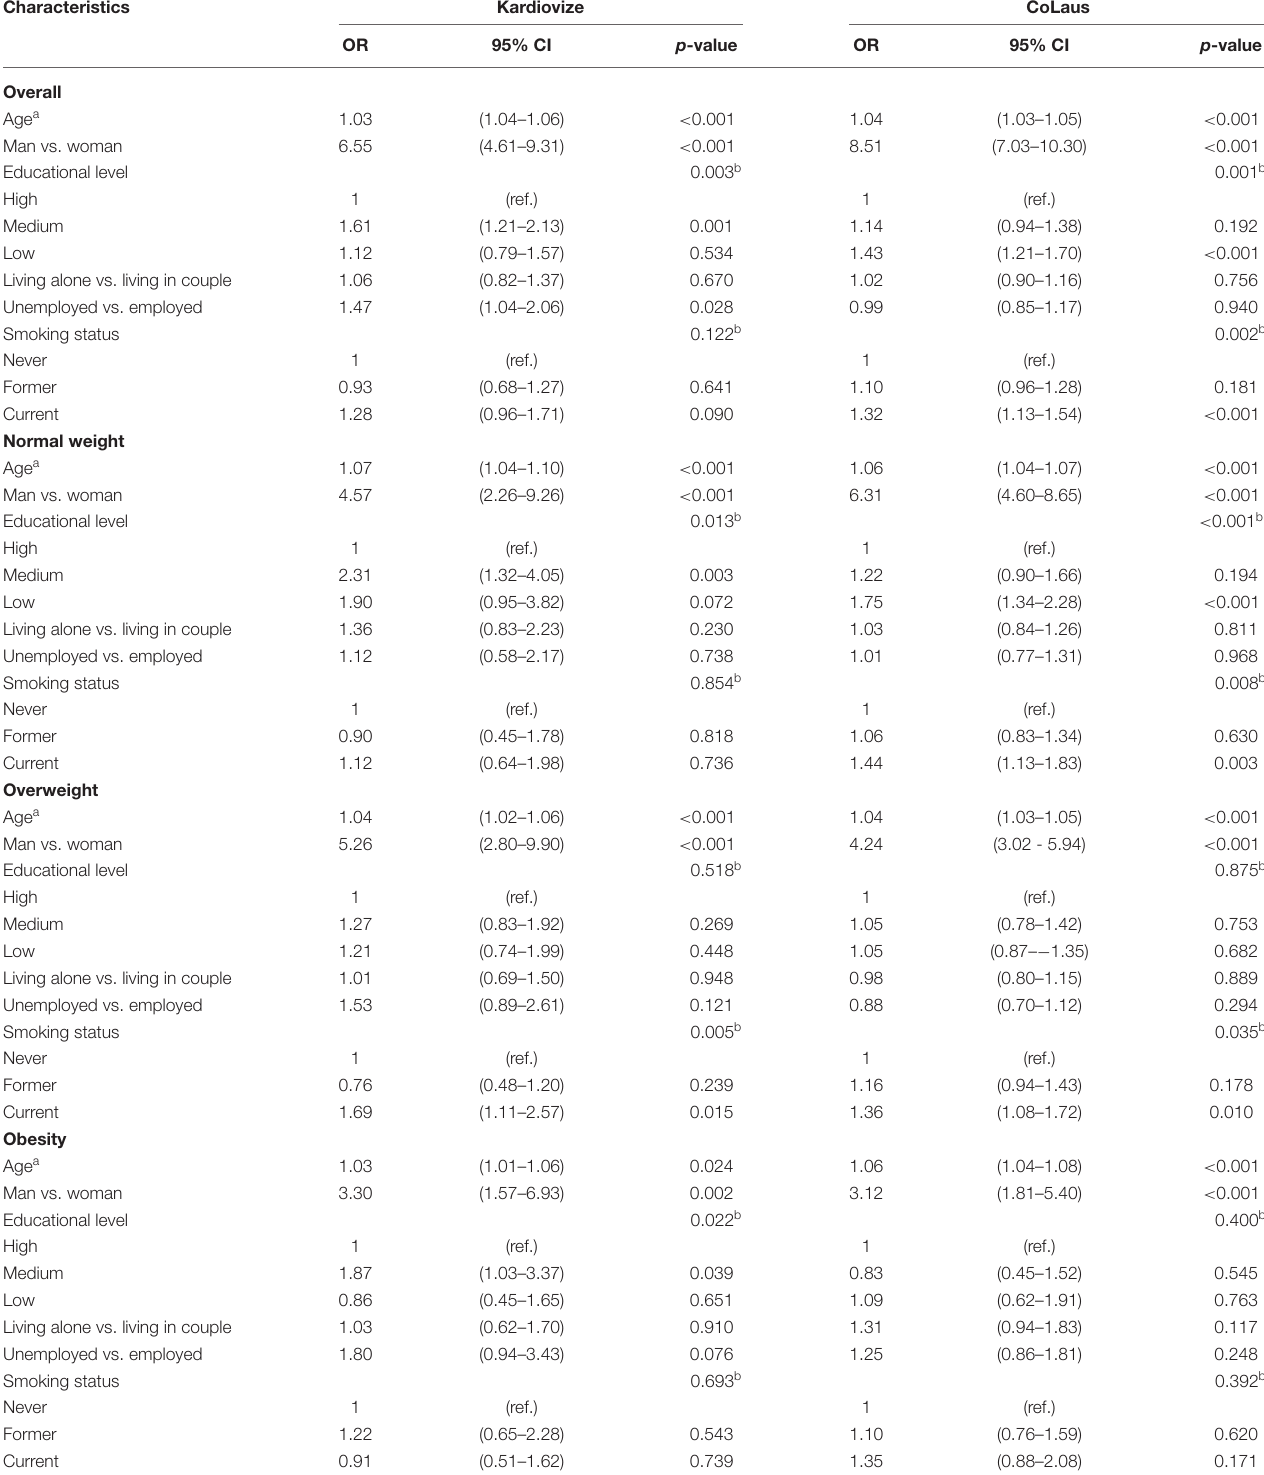
TABLE 3 | Multivariable associations of social and behavioral factors with metabolically unhealthy status.